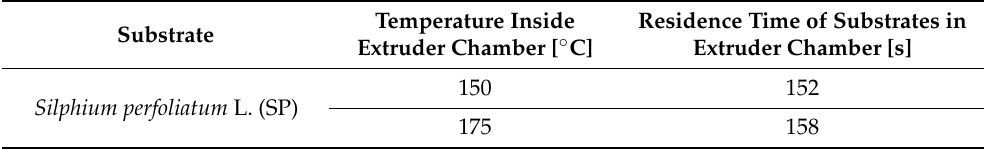
Table 1. The temperature inside the extruder chamber and the residence time of the lignocellulosic substrates in the extruder